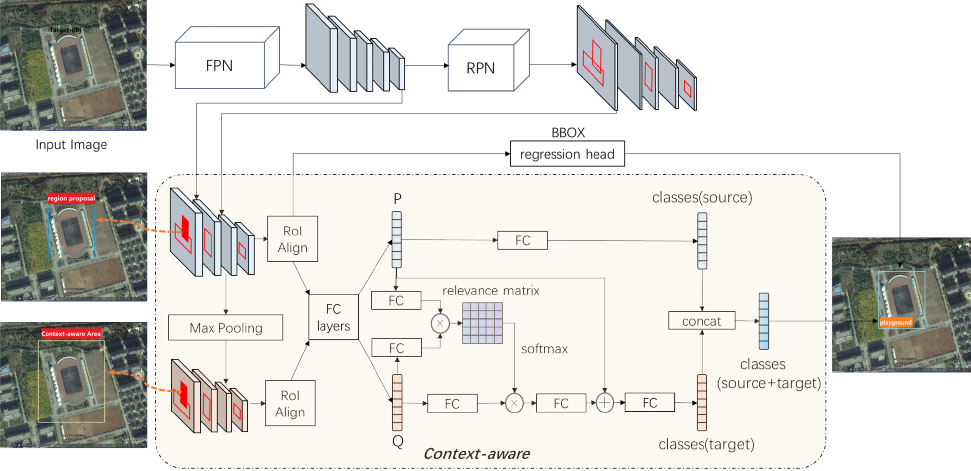
Figure 18. The framework of our proposed method. We regard base classes and novel classes as the source domain and the target domain, respectively. The context-aware module explores the contextual information to guide the classification in the target